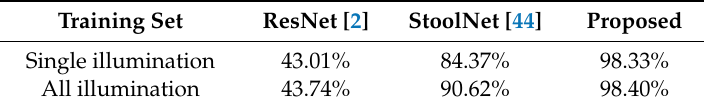
Table 2. Accuracies of di ff erent